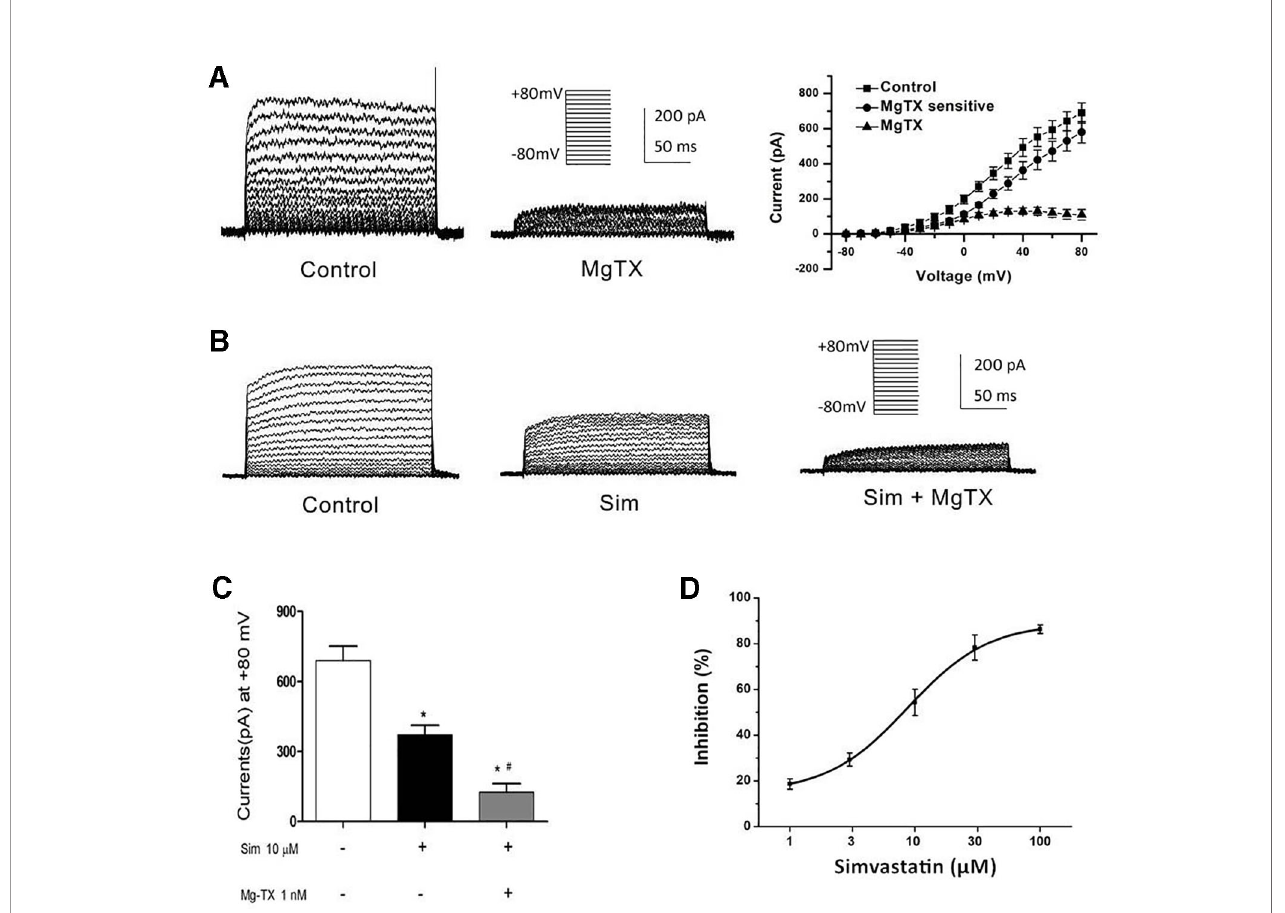
FIGURE 3 | Effects of simvastatin on Kv1.3 current intensity change in THP-1 cells measured by whole-cell clamp patch. (A) Kv1.3 current was detected with a series of test potentials of 300 ms duration from − 80mV to +80mV in 10 mV increments from a holding potential of − 70mV. The currents were blocked by 1 m M MgTX. (B) Simvastatin treatment signi fi cantly inhibited the current intensity of Kv1.3. (C) The 10 m M simvastatin treatment remarkably inhibited the current intensity of Kv1.3 vs. control, * P < 0.05 vs. controls, and the addition of 1 nM MgTX further inhibited the current intensity compared with the simvastatin treatment alone, # P < 0.05 vs. inhibitor treatment, when the voltage was set at +80 mV, n = 4 for each group. (D) The does-response data of the Kv1.3 current at +40 mV was summarized (n = 4 for each concentration) and fi tted with Boltzmann equation. The IC 50 was calculated to be 8.75 ± 1.25 m